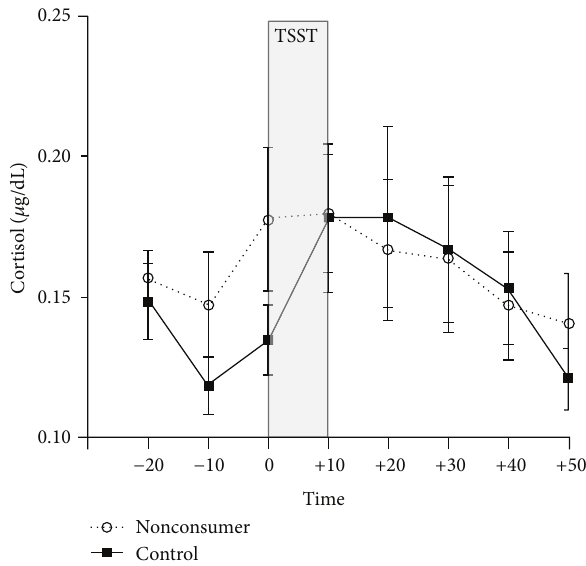
Figure 4: Comparison of reactive salivary cortisol levels in response to the Trier Social Stress Test in nonconsumers of self-help books andacontrolgroupof14age-andsex-matchedindividualsextracted from our database. The error bars represent the standard error of the